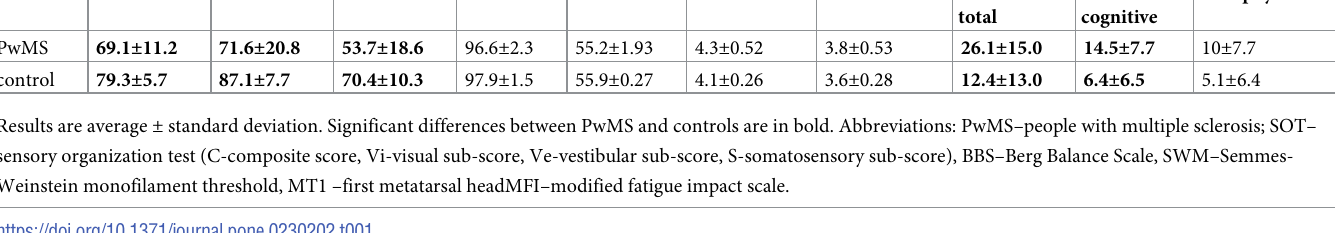
Table 1. Clinical test results for people with MS and age-matched controls.